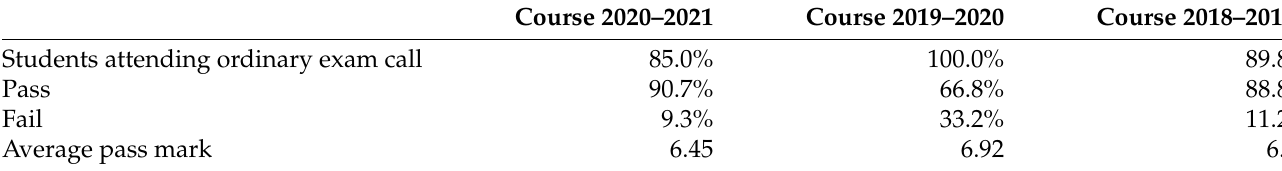
Table 14. Results of Nursing Ordinary Exam